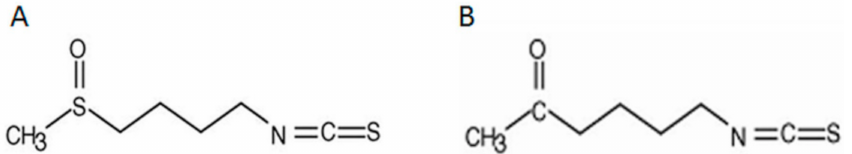
Figure 1. Structural formulae of isothiocyanates: ( A ) sulforaphane; ( B ) 2-oxohexyl